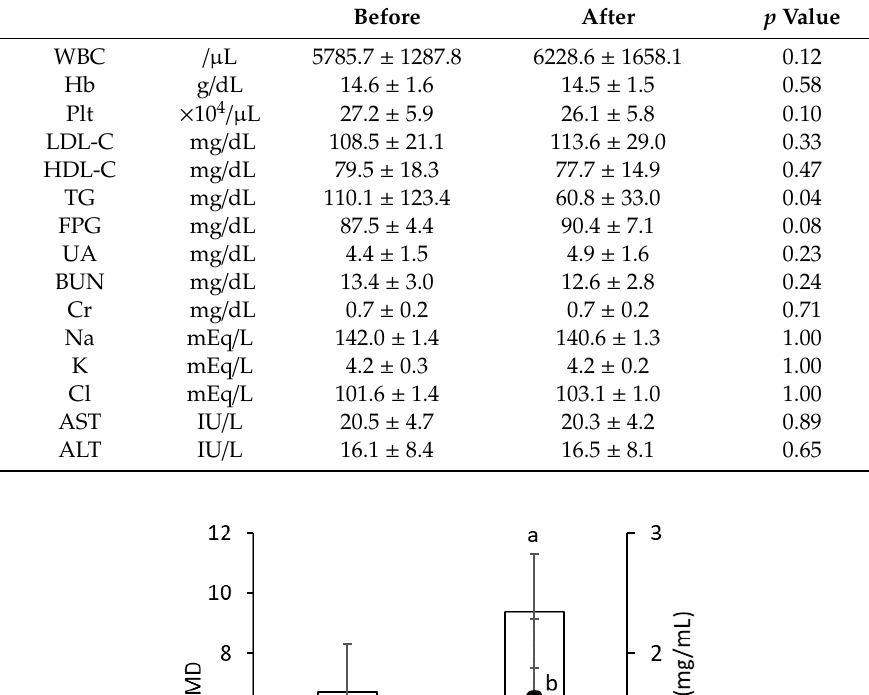
Table 3. General biochemical examination of blood collected from participants.